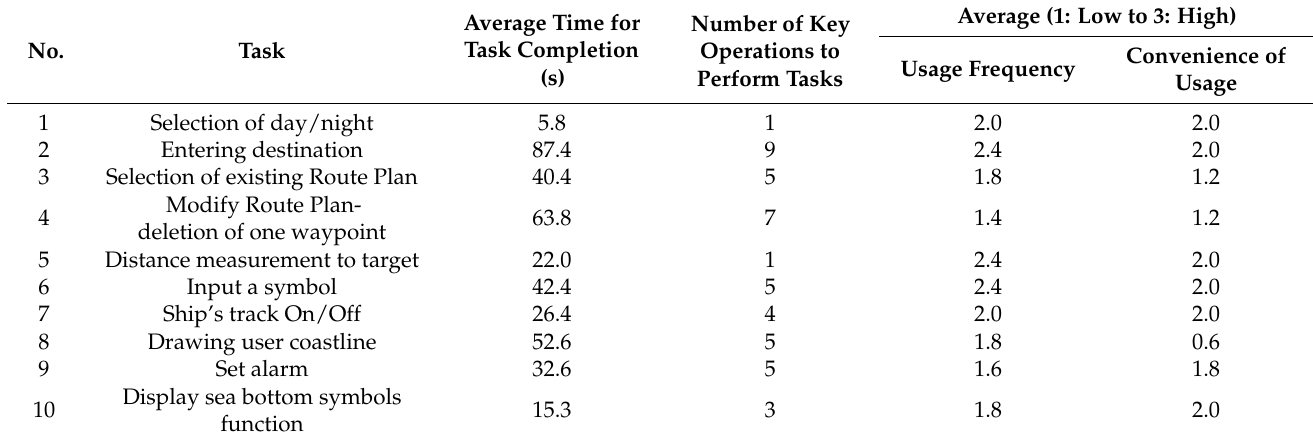
Table 7. User-survey results on the frequency of use of GPS plotting functions.